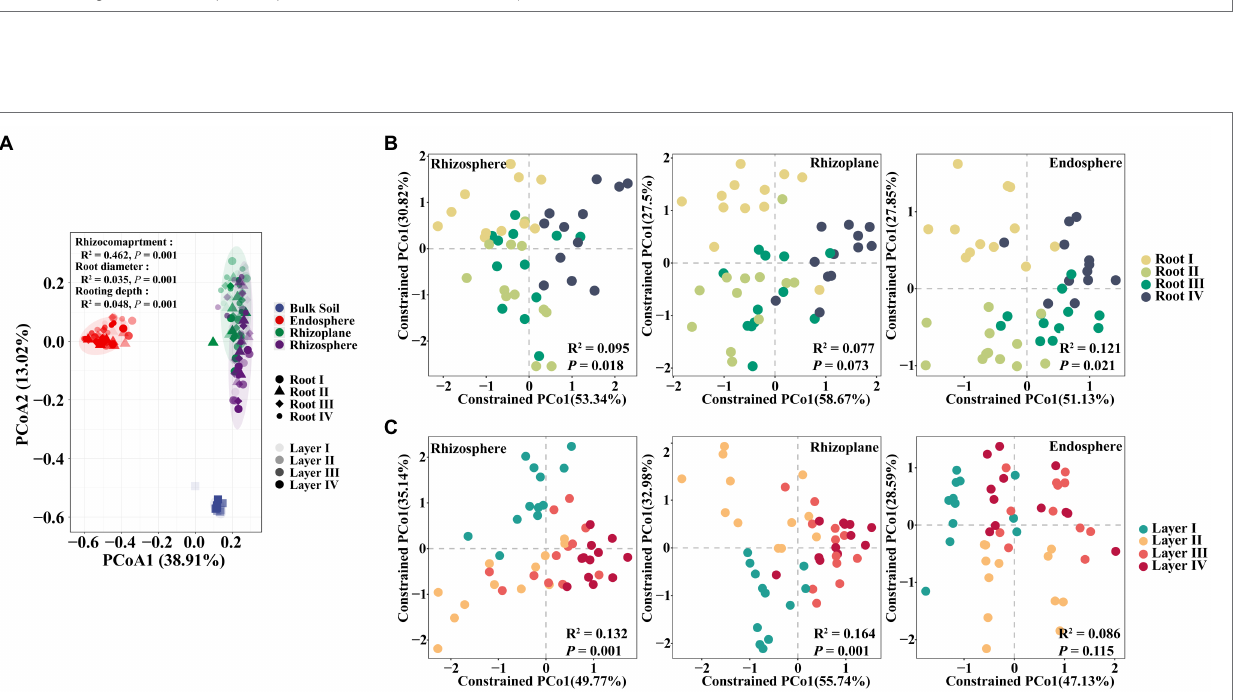
FIGURE 1 | The boxplot of Shannon diversity and OTU richness (number of observed OTUs) of bacterial communities in rhizosphere, rhizoplane and endosphere among different root diameters ( A ; n = 12) or different rooting depths ( B ; n = 12). Different letters above the box indicate significant differences ( p < 0.05, “ns” to indicate non-significance, multiple comparison with Kruskal-Wallis tests).